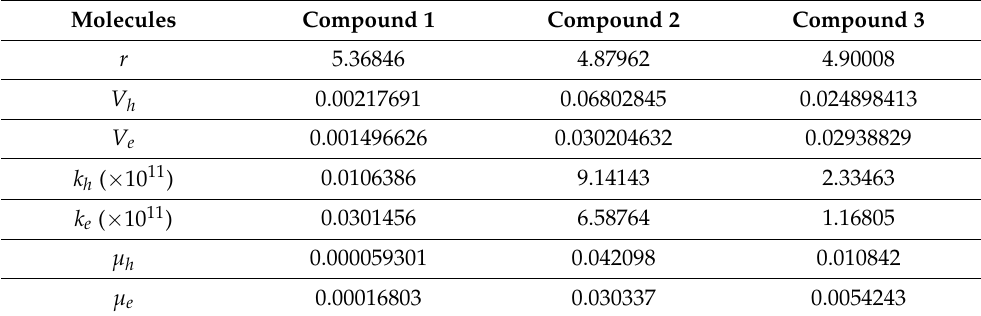
Table 7. The transfer integrals V (eV), r (Å) is centroid to centroid distance, hopping rates k (s − 1 ) and mobilities µ (cm 2 V − 1 s − 1 ) of